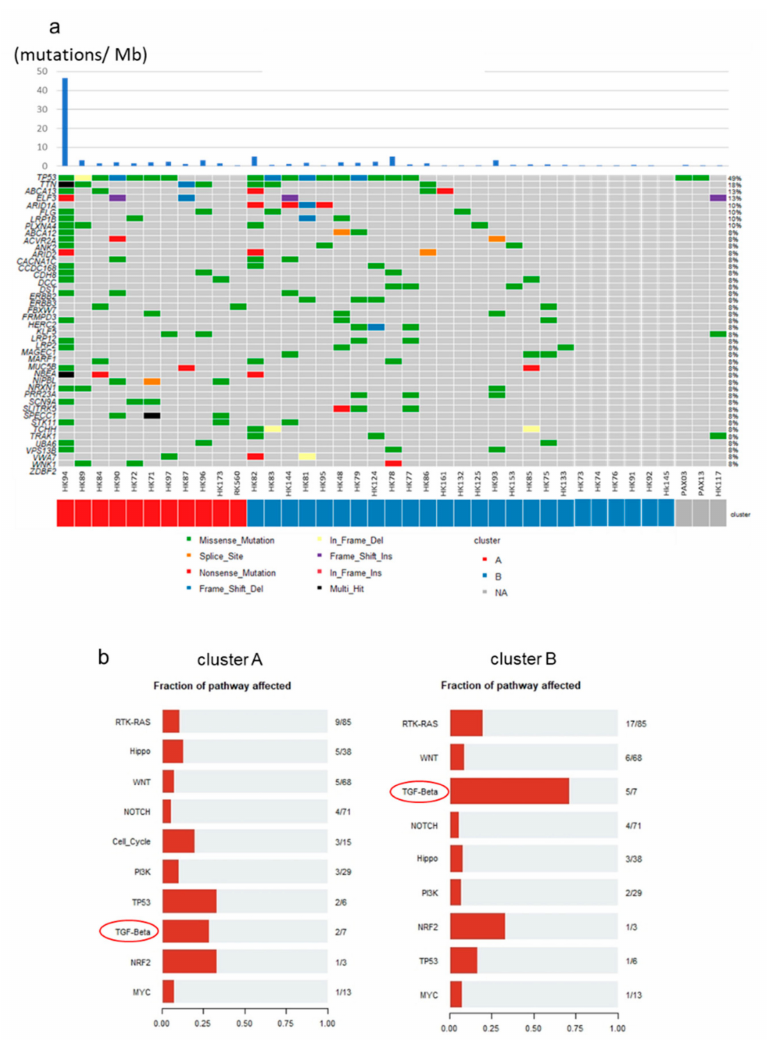
Figure 6. Mutational profiles of GBCs. ( a ) Landscape of somatic mutations of 39 GBCs in Clusters A and B. Three samples had no RNA-seq data and were not classified. Single nucleotide variations (SNVs)/INDELs across 39 GBC patients with different mutation types are coded by different colors. The upper panel shows the somatic mutation number per Mb. ( b ) Fraction of pathways affected; this figure was prepared from the number of related genes in each cluster. Each pathway-related gene set was used, as revealed from The Cancer Genome Atlas (TCGA). In total, 5 of 7 (71.4%) and 2 of 7 (28.6%) genes related to the TGF- β pathway from Cluster B and A had mutations,